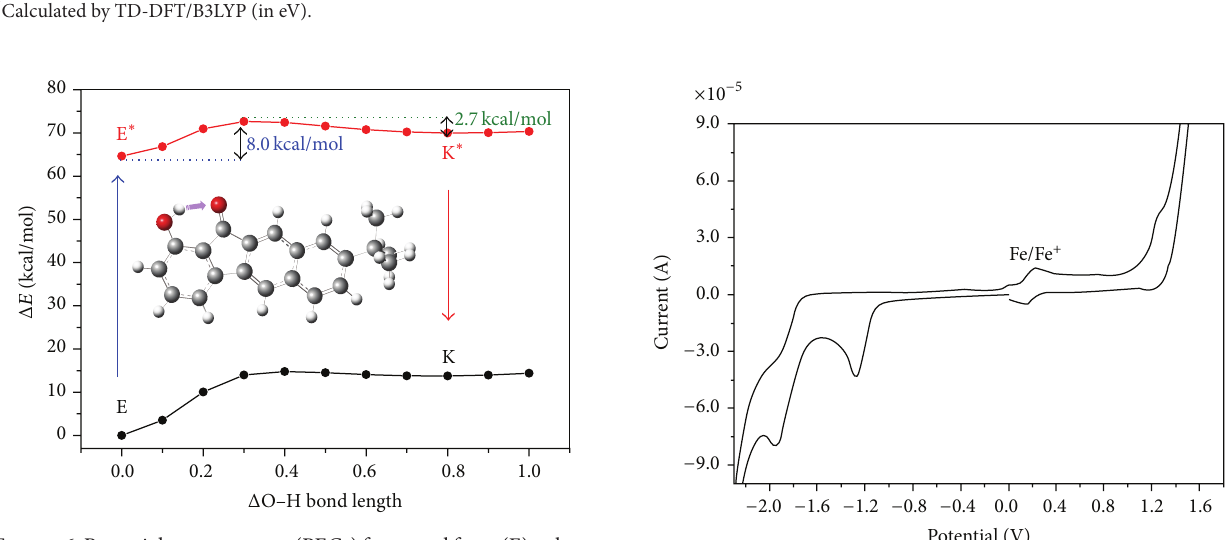
Figure 6: Potential energy curves (PECs) from enol form (E) to keto form (K) of 1 at the ground state and excited state. The calculations are based on the optimized ground state geometry (S 0 state) at the B3LYP/6-31G ∗∗ /level using Gaussian 03W.